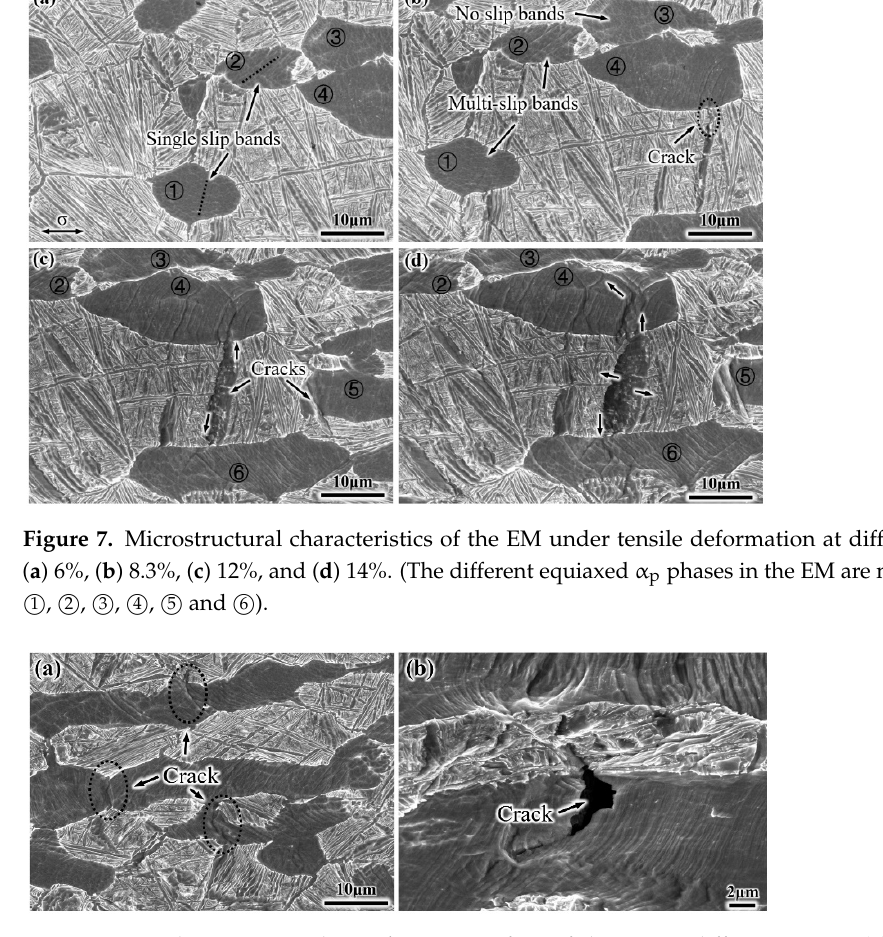
Figure 8. Cracks initiate at the α p / β trans interface of the EM at different strain: ( a ) 11.6% and ( b ) 14.7%.